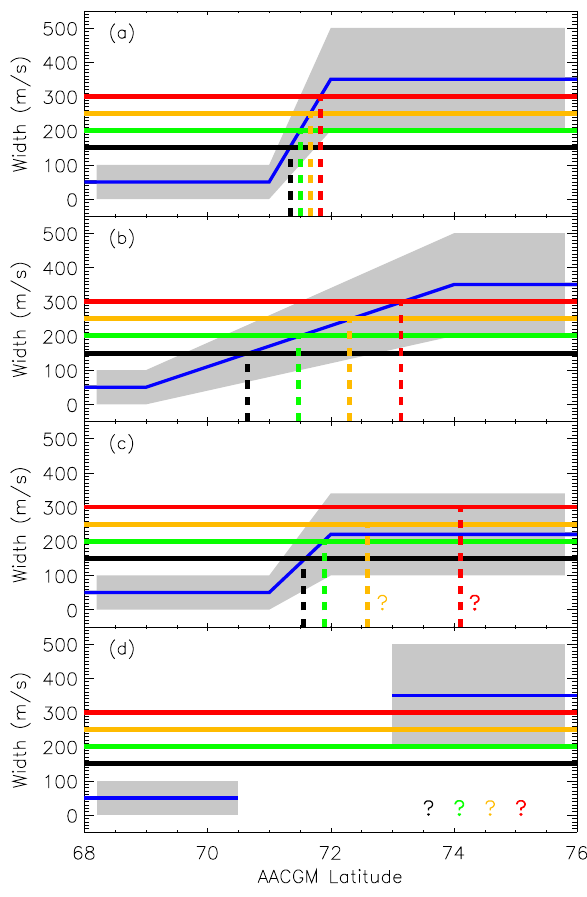
Fig. 1. Four possible spectral width transition scenarios (see text for full details). In each panel the blue line represents the variation of the median of the spectral width distribution with latitude and the grey area is the approximate half-width of the distribution. The four horizontal lines represent four different spectral width thresh- old values, 150m/s (black), 200m/s (green), 250m/s (yellow), and 300m/s (red). The four dashed vertical lines represent the best esti- mate of where a boundary will be determined. The question marks signify a questionable or non-existant boundary